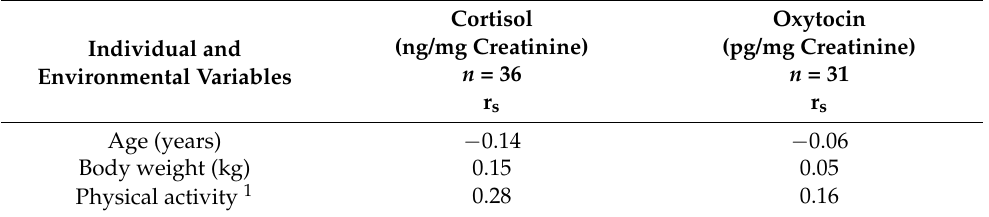
Table 2. Correlation between hormone concentrations and individual and environmental variables.